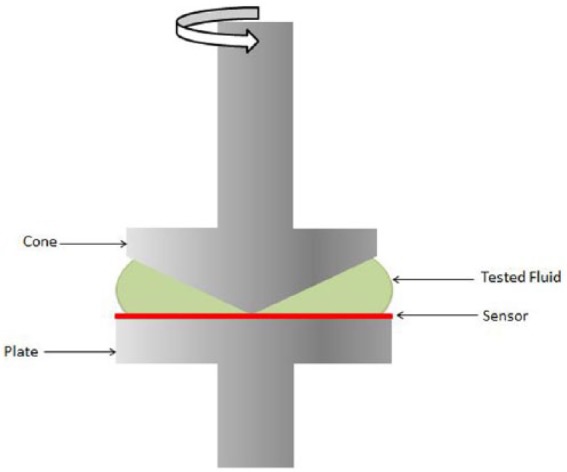
Rheometer diagram.